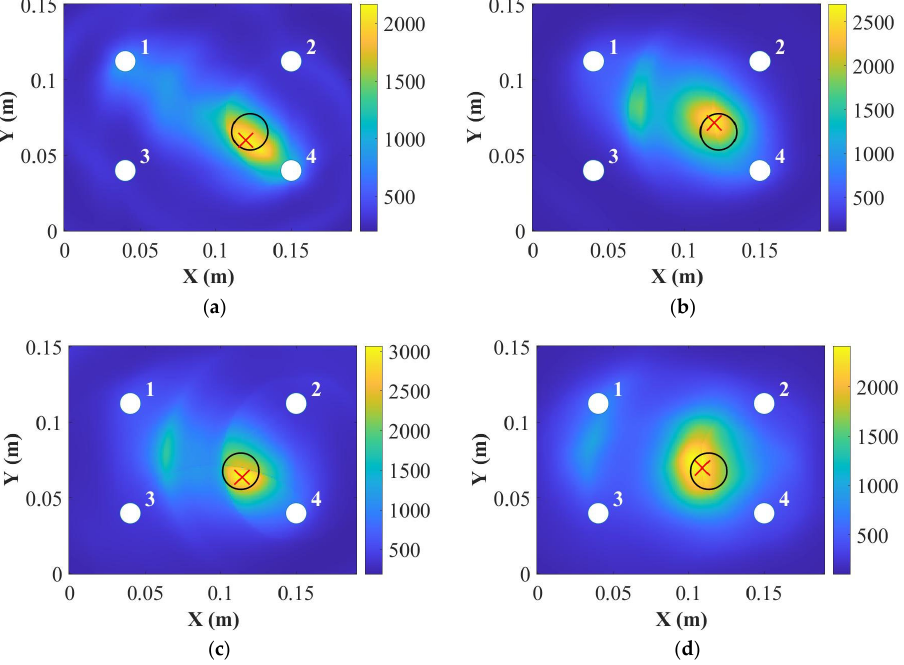
Figure A2. Damage localisations for the 2 mm thick panel at 50 kHz ( a ) and 250 kHz ( b ) and for the 4 mm thick panel at 50 kHz ( c ) and 250 kHz ( d ) (where “ ○ ” is the position for real damage and “ × ” is the position for predicted damage).